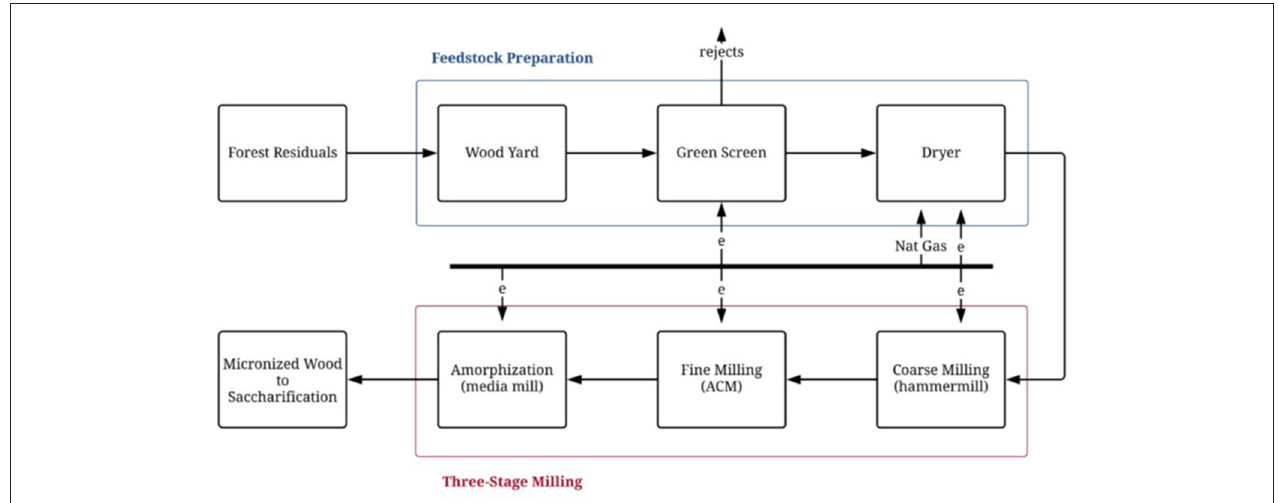
FIGURE 1 | Process flow chart for mechanical pretreatment of biomass using a three-stage milling process.